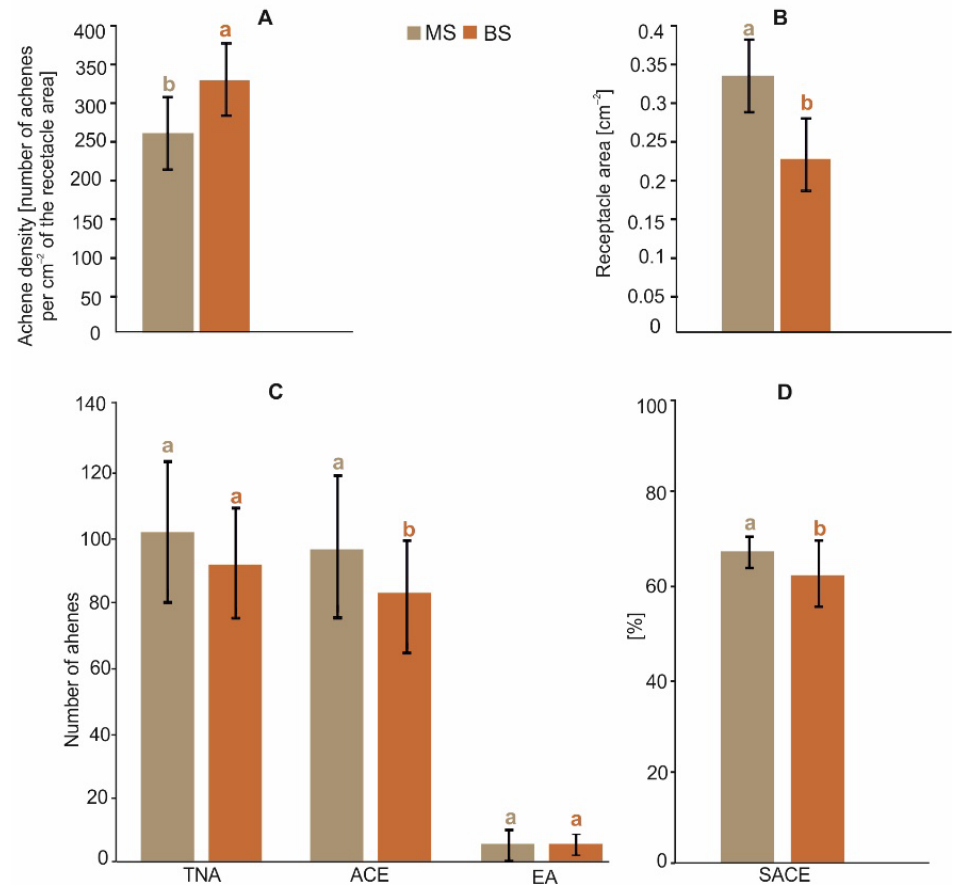
Figure 3. Comparison of achene density ( A ), receptacle area ( B ), number of achenes ( C ), and percent share of achenes ( D ) in two positions of A. montana flower heads on the plant (mean ± SD). MS—main stem; BS—branch stem; TNA—total number of achenes; ACE—number of achenes containing a developed embryo; EA—number of empty achenes; SACE—percent share of achenes containing a developed embryo. Different lowercase letters indicate significant differences between the means of two groups according to the t -test ( p < 0.05). Figure 4 shows the results of the PCA ordination on the basis of six characteristics of 25 infructescences located on the main stems, and 25 infructescences located on the branch stems. The two PCA axes explained 97.79% of the total variance, and they are sufficient to describe the analyzed samples (Table 1). The eigenvalues of the first (2.35), second (2.26), and third axis (1.25) indicate the presence of three gradients, within which the samples are differentiated in terms of the TNA, ACE, AD, SACE, RA, and AD values. The TNA, AC, SACE, and RA parameters are clearly positively correlated with the first axis, whereas EA and AD are negatively correlated. The TNA, ACE, EA, and RA traits are positively correlated with the second axis, whereas SACE is negatively correlated. The variation between the group of infructescences located on the main stems and the group of infructescences located on the branch stems is evident as well. Two groups can be distinguished in the ordination space of PCA. The infructescences located on the main stems are characterized by the highest values such parameters as TNA, AC, SACE, and